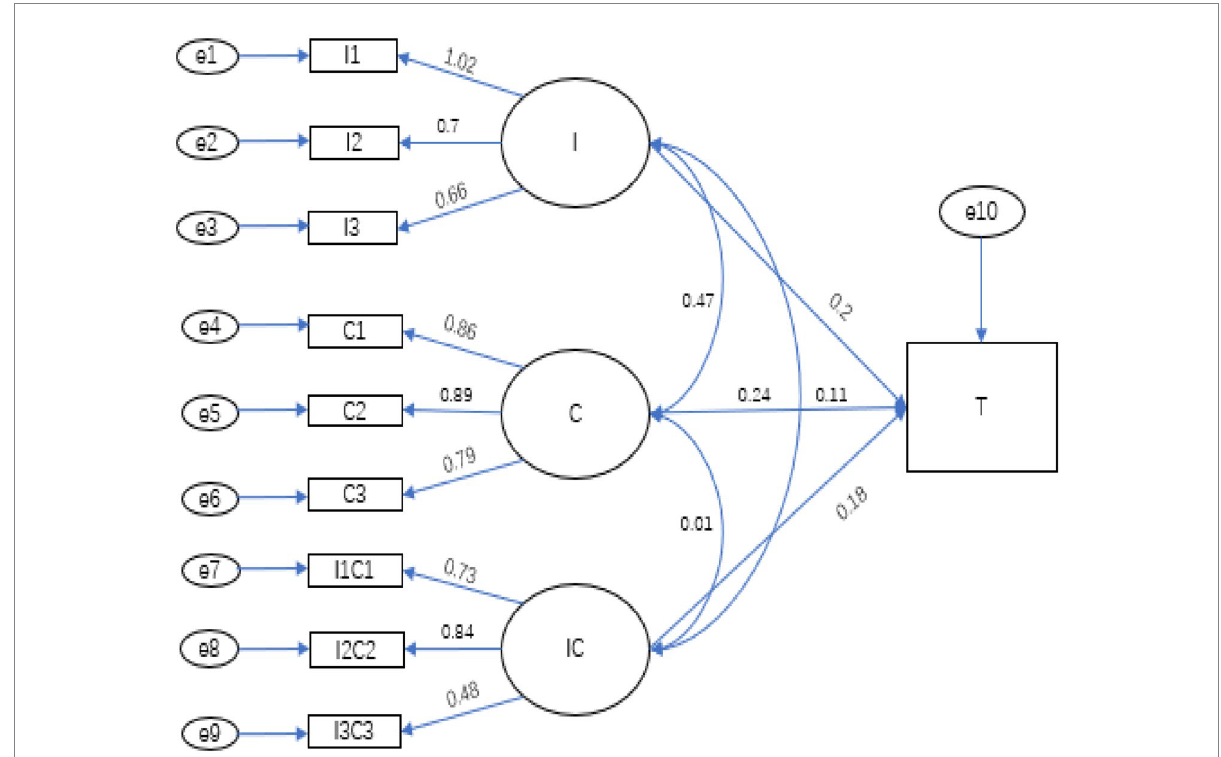
FIGURE 3 Pathways from opportunity (giving rise to temptation) to fraudulent behavior. “T,” fraud tendency.